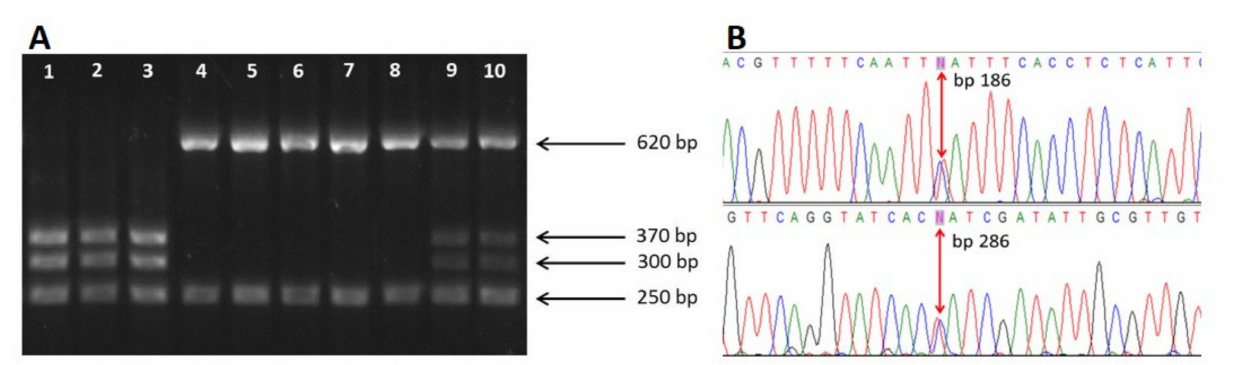
Figure 1. ( A ) Restriction fragment length polymorphism patterns of the ITS region of the rDNA of Anisakis larvae using the Hinf I restriction enzyme. Lines 1–3: A. pegreffii (370, 300, 250 bp); Lines 4–8: A. simplex (s.s.) (620, 250, 80 bp); Lines 9–10: Hybrid genotype between A. pegreffIi and A. simplex (s.s.) (620, 370, 300, 250, 80 bp). ( B ) Partial EF1 α -1 nDNA sequences of hybrid specimens, highlighting the two diagnostic positions, bp 186 and 286, respectively, using Sequence Scanner Software v